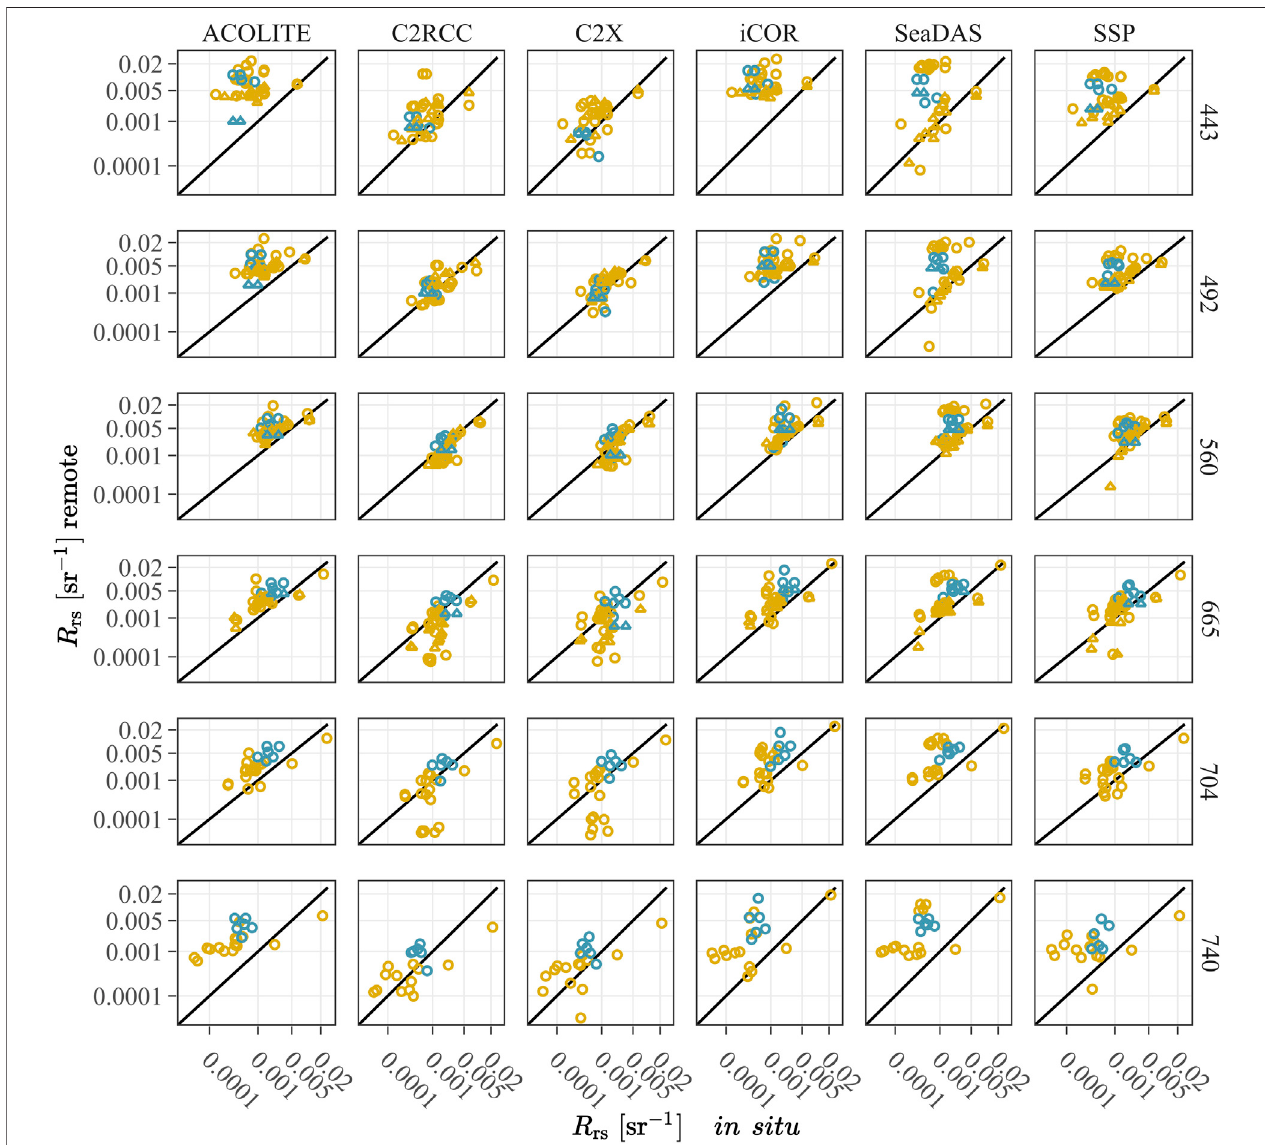
FIGURE8| R rs measured insitu and remotelyintheEGSL(yellow) and inJB(blue) byMSI(circle)andOLI(triangle) intheblue(443and 482,492 nm,respectively), green (560, 561 nm, respectively), red (665, 655 nm, respectively), and NIR (704, 740 nm, MSI only) bands. The solid black line represents the 1:1 relation.